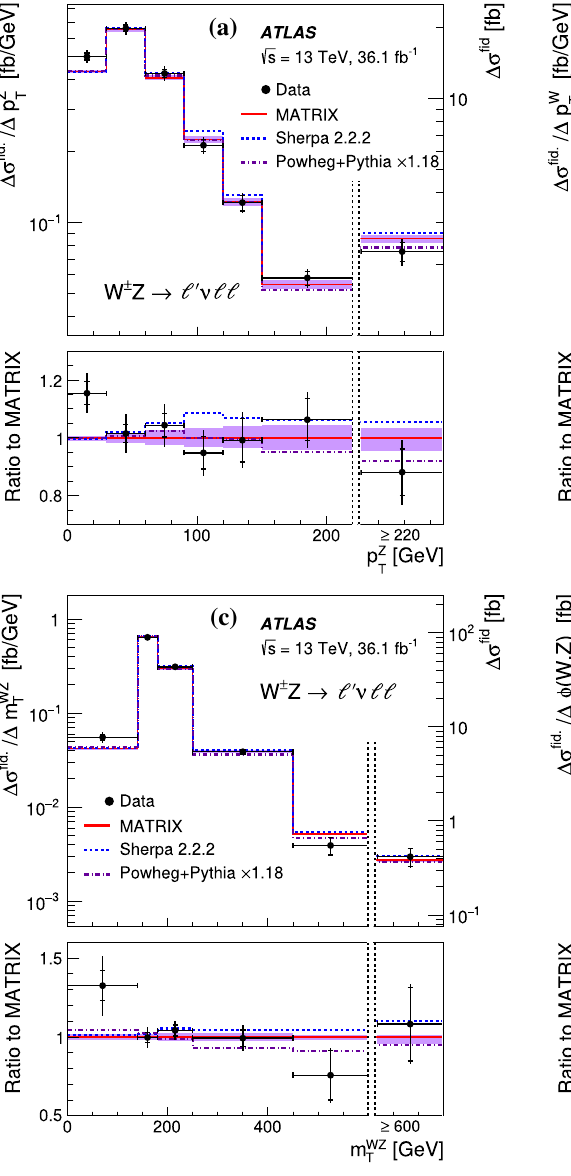
Fig. 4 The measured W ± Z differential cross section in the fiducial predictions. The predictions from the Powheg+Pythia and Sherpa phase space as a function of a p Z , b p W , c m WZ and d (cid:10)φ( W , Z ) . The MC generators are also indicated by dotted-dashed and dashed lines, T T T inner and outer error bars on the data points represent the statistical and respectively. In a – c , the right vertical axis refers to the last cross-section total uncertainties, respectively. The measurements are compared with point, separated from the others by vertical dashed lines, as this last bin the NNLO prediction from MATRIX (red line, see text for details). The is integrated up to the maximum value reached in the phase space and violet band shows how the QCD scale uncertainties affect the NNLO the cross section is not divided by the bin